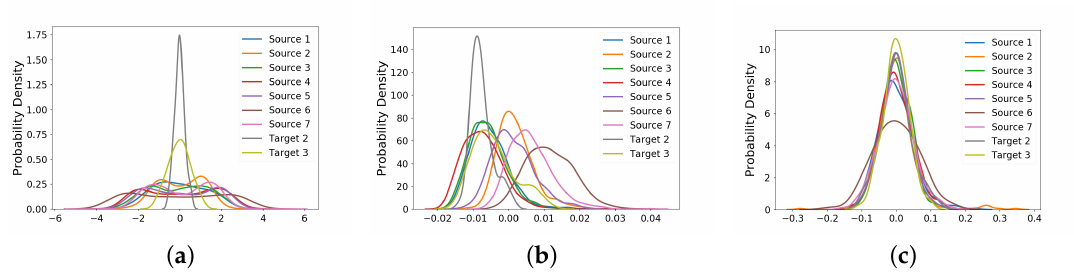
Figure 10. Probability density distribution of nine training bearings with ( a ) raw time signal, ( b ) HHT marginal spectrum feature, and ( c ) deep feature extracted by DAE with domain adaption.